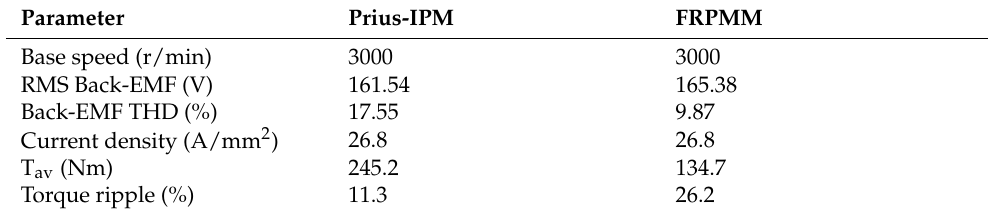
Table 4. Quantitative comparison of Prius-IPM and